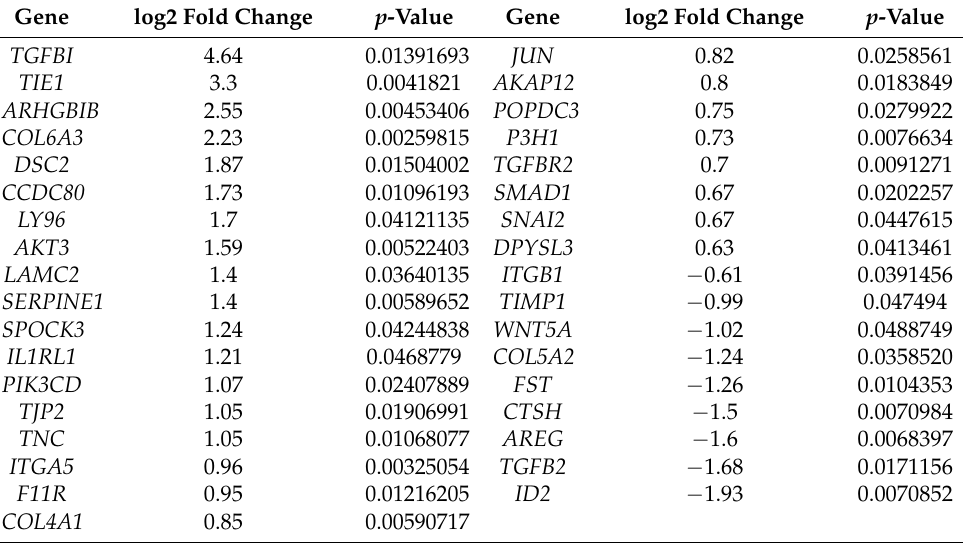
Table 8. Differentially expressed genes in T oe + EV PIC versus WT + EV